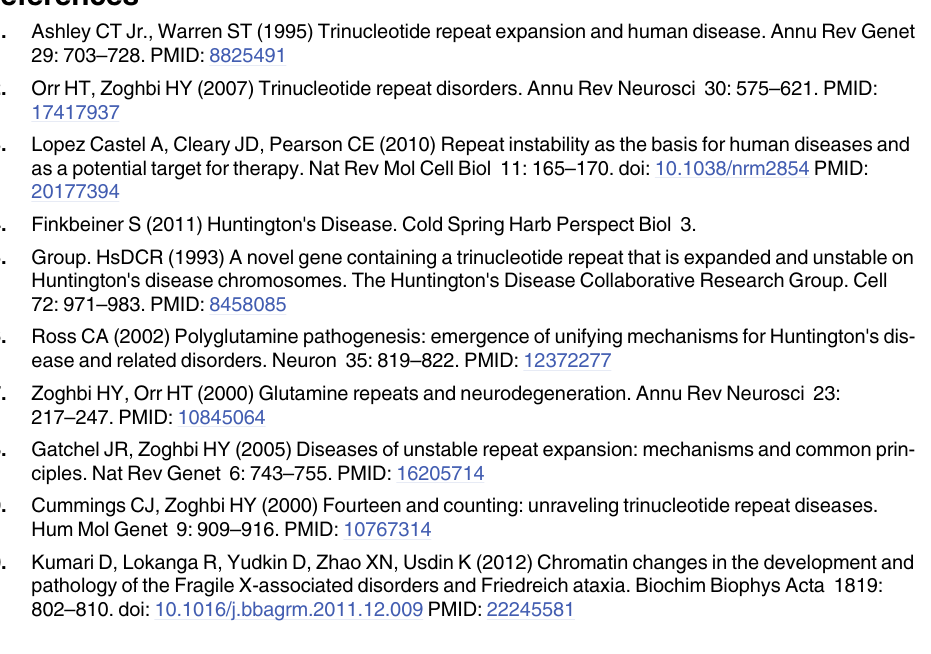
S1 Table. Embryonic lethality of Supt4h knockout mice. S2 Table. Nucleotide sequence of primers used in this